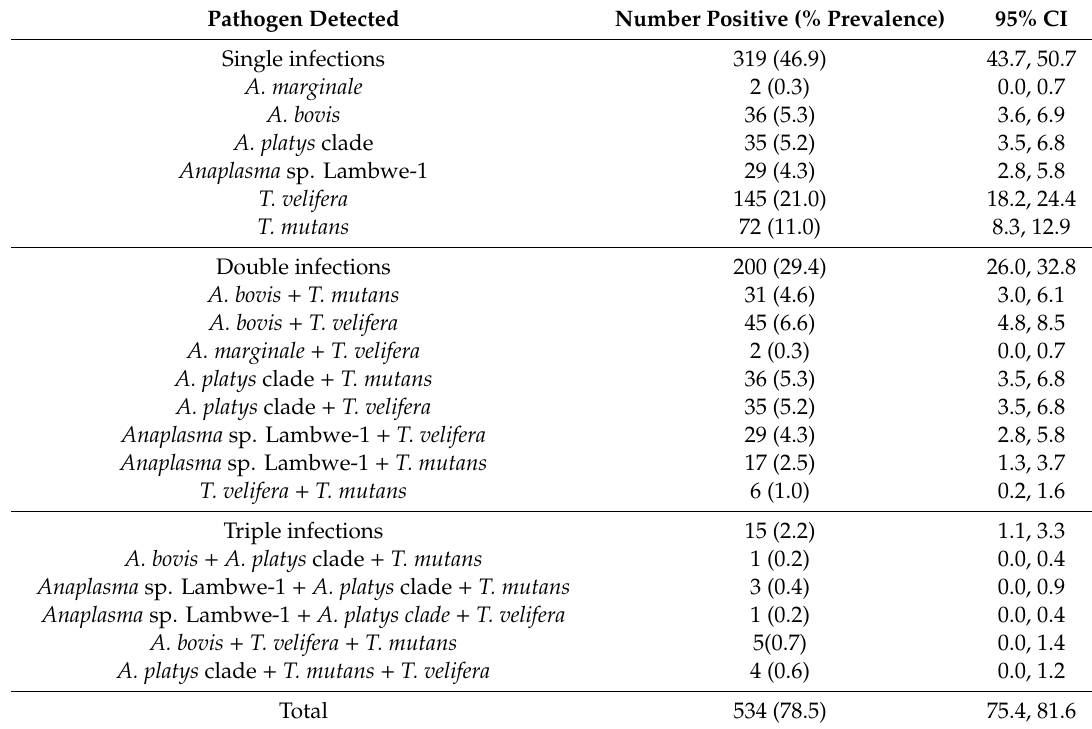
Table 3. Single and multiple infections detected in cattle in the wildlife–livestock interface in Lambwe Valley, western